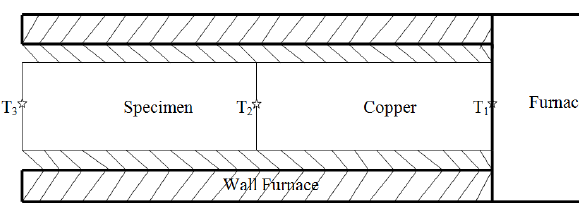
Figure 2: A scheme view for the placement of specimens inside